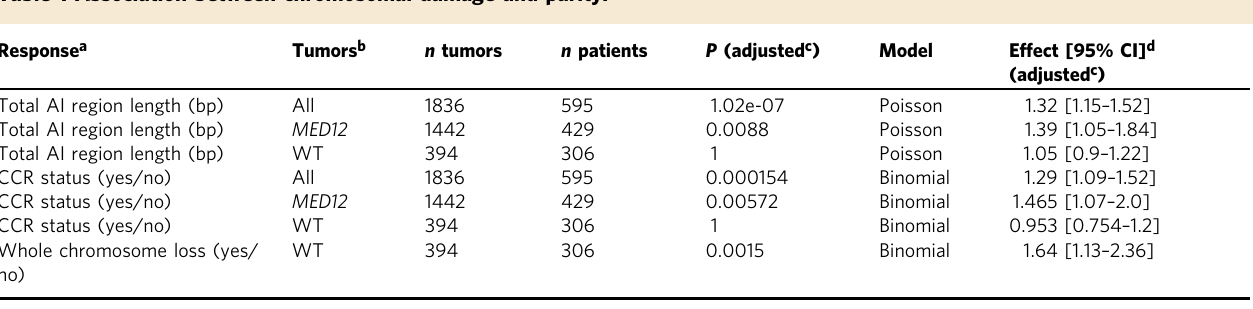
bp base pairs, AI allelic imbalance, CCR complex chromosomal rearrangements. a Parity is the predictor. Confounders: history of ever smoking (yes/no), age, menopause status (pre/hormonal replacement therapy/post), and combined oral contraceptive use (never/ever). b All: all tumors regardless of mutation status; MED12 : only the MED12 mutation-positive tumors; WT: only the MED12 mutation-negative tumors. c Bonferroni adjusted two-sided P-values and 95% con fi dence intervals (adjusted alpha 0.05/11). d For binomial regression, odds ratio is reported and for Poisson regression rate